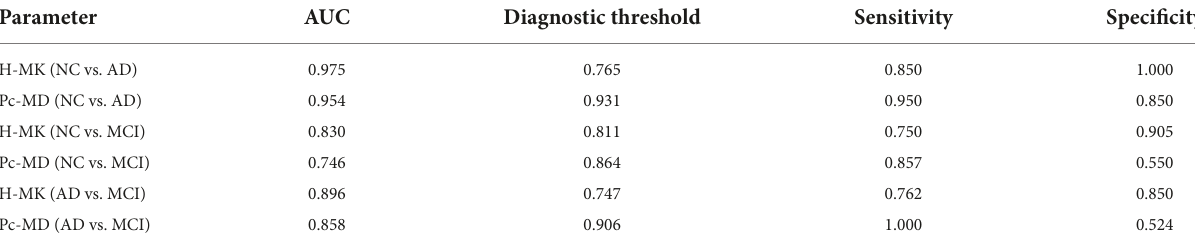
TABLE 10 Coordinate points of receiver operating characteristic (ROC) curve. Parameter AUC Diagnostic threshold Sensitivity